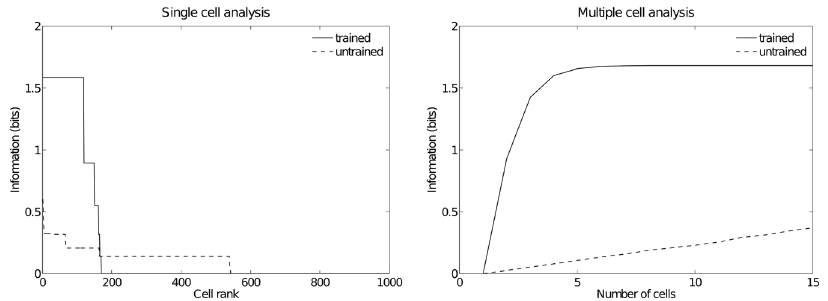
Figure 9. Information analysis for larger shifts. Analysis of the information about where the target object is with respect to the hand conveyed by the output (fourth) layer neurons before and after training. The left plot shows the amount of single cell information carried by individual output cells in rank order. After training, it was found that 119 cells reached the maximum amount of single cell information of 1.58 bits. These cells responded perfectly to just one of the three hand-object configurations, and responded to that configuration across all five retinal locations. The right plot shows the multiple cell information measures calculated across 15 cells with maximal single cell information. It can be seen that, after training, the multiple cell information asymptotes to the maximal value of 1.58 bits. This confirms that all three hand-object configurations are represented by the output cells.